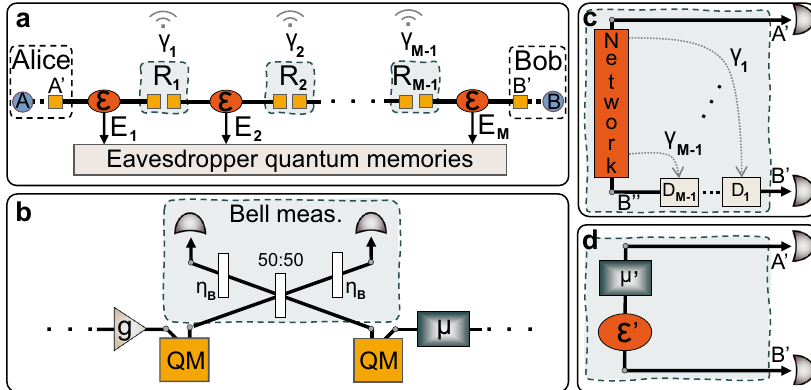
Fig. 2 Quantum communication chain within a network. a An arbitrary route between Alice and Bob can be seen as a linear chain between them that consists of M links and M − 1 stations ( R i 's). b Each station can encompass a noiseless linear ampli fi er (NLA, g ), a bipartite entanglement TMSV source ( μ ), a couple of QMs, and a non-ideal Bell detection, whose loss is simulated by a couple of beam splitters with transmissivity η B . c A Gaussian quantum network provides the end parties with a Gaussian bipartite state, called the network state ρ A 0 B 0 . Displacement operations need to be applied according to the information received form the stations, as shown in a . d The effect of the Gaussian quantum network in c can be simulated via a one-way Gaussian protocol with an equivalent source μ 0 , and an equivalent channel, E 0 , with loss η 0 and excess noise ξ 0